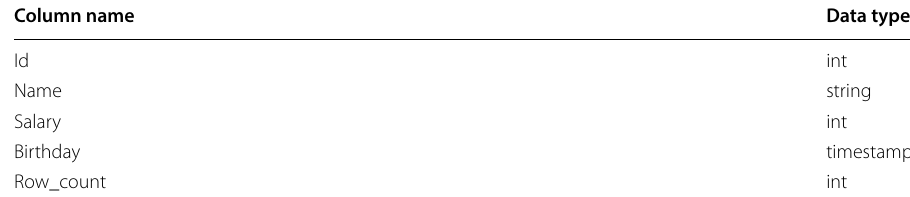
Table 2 Deduplicated databases schema—“Users" table